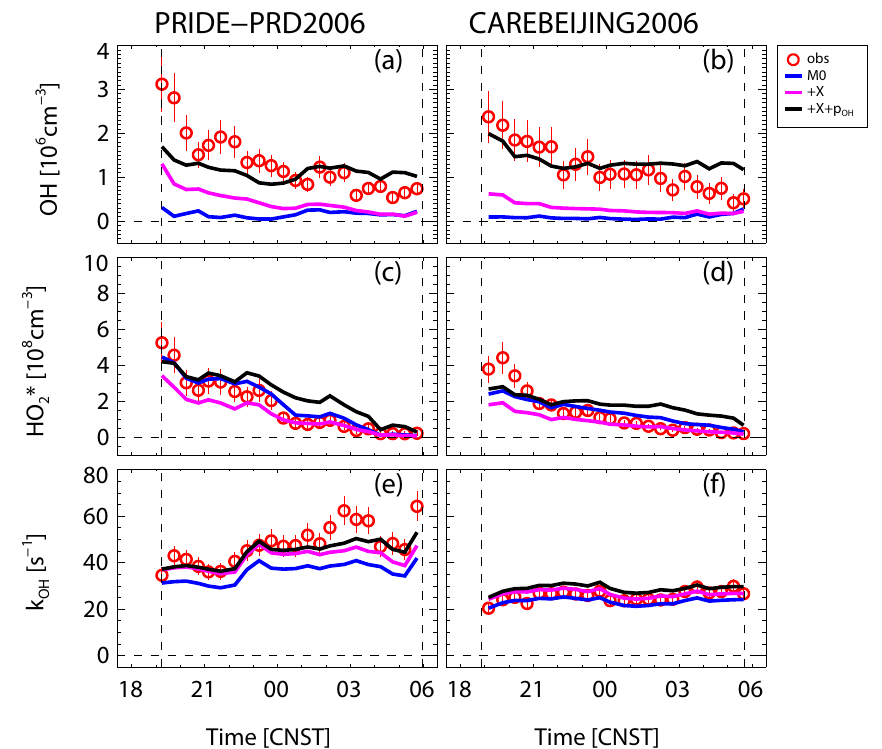
Figure 10. Model–measurement comparison of mean nighttime variations of OH, HO ∗ , and k OH for PRIDE-PRD2006 and CAREBEI- 2 JING2006. The model runs M0+X+ p OH and M0+X assume additional radical recycling by X and are calculated with and without extra primary OH production ( p OH = 1ppbh − 1 ), respectively. For comparison, observational and base model (M0) data from Fig. 3 are shown. Error bars attached to the observed data points denote the combined uncertainty from precision and accuracy (1 σ